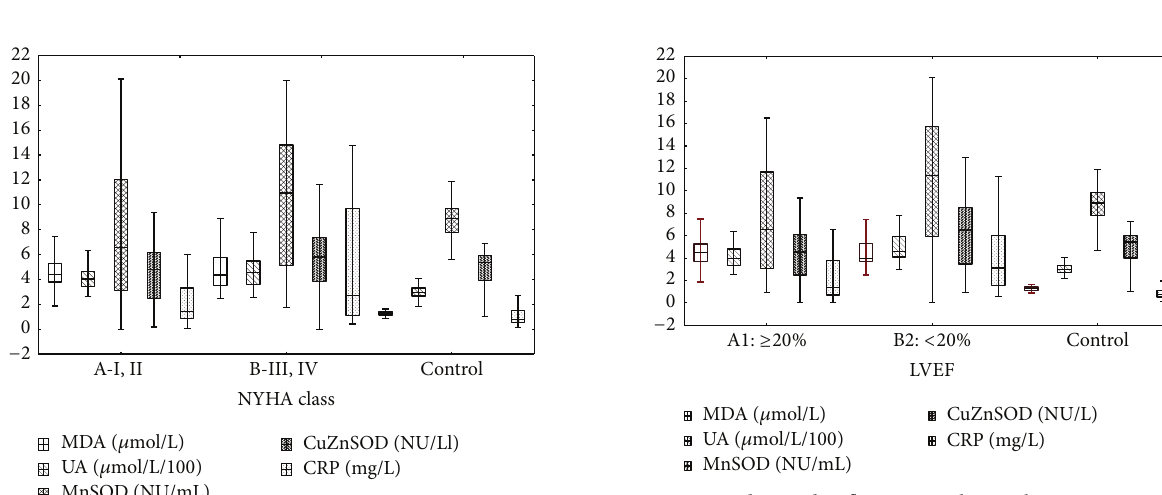
Figure 2: Redox and inflammation biomarkers in patients with LVEF ≥ 20%, < 20%, and control. Median [25%–75%] and 1.5IQR. of both izoenzymes SOD in comparison to patients from group A1. MDA concentration was comparable (Figure